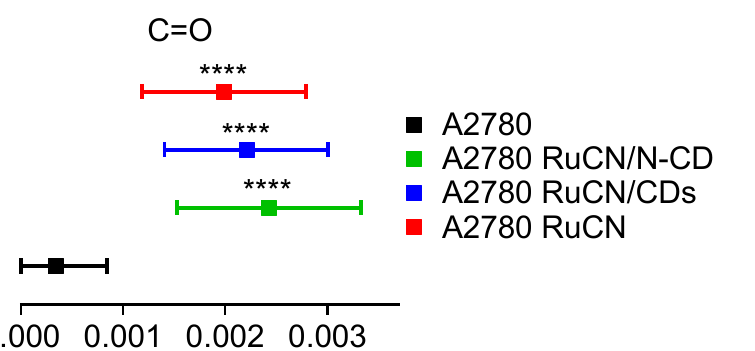
Figure 8. The changes of the C=O band peak area after the indicated treatment conditions. The values are presented with the mean ± SD, and all the values are compared to the control (A2780 untreated cells, black color). **** indicates values that are significantly different ( p ≤ 0.0001).